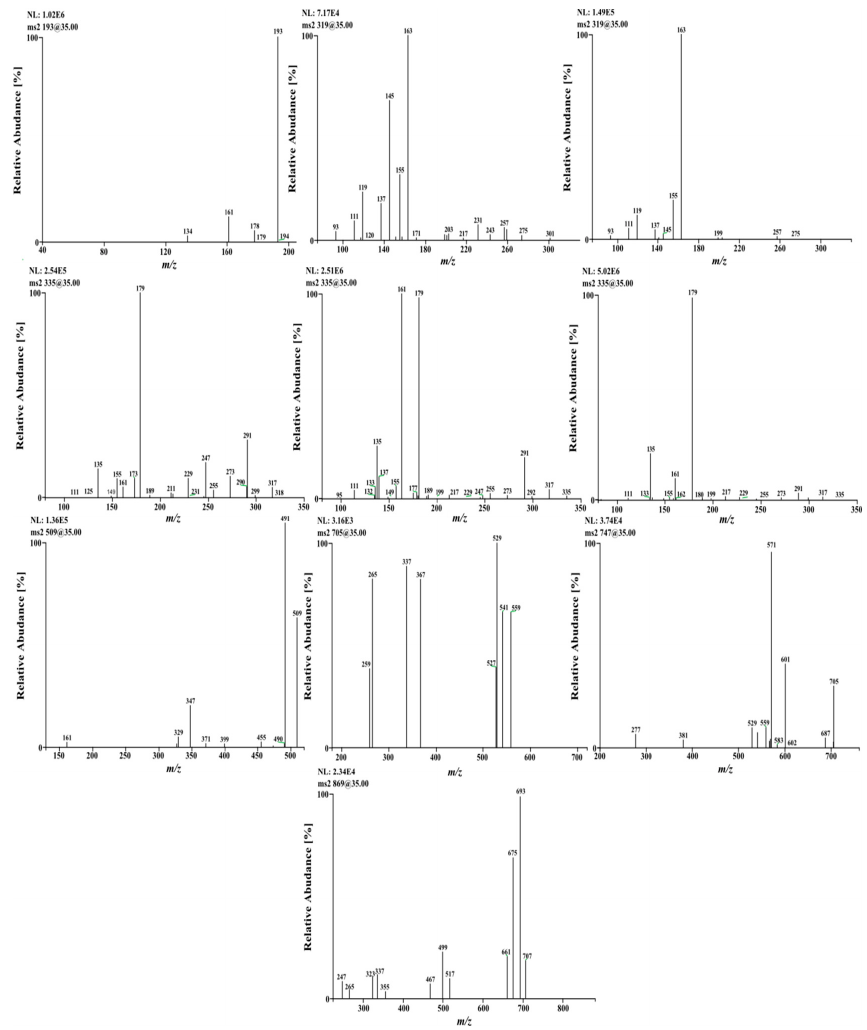
Figure 2. Product ion spectra of date palm male flowers components ([M − H] − ): MS 2 of regioisomers at m / z 319, dimers at m / z 335, at m / z 509, at m / z 705, at m / z 747, and 869.